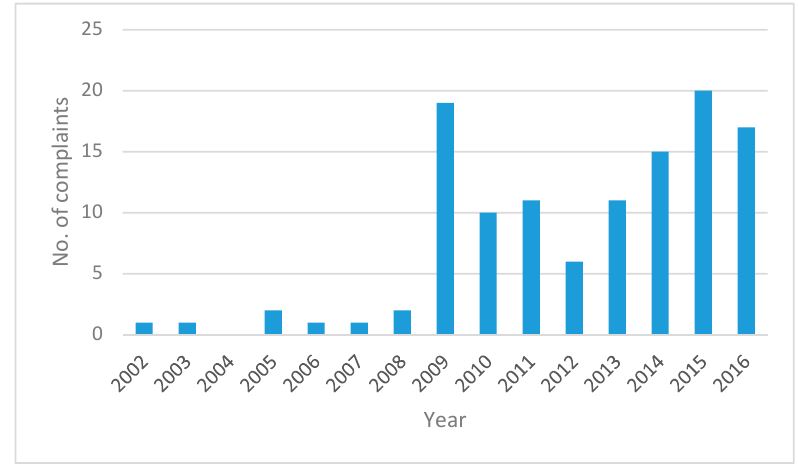
Figure 1. Recorded heat-related formal complaint calls to SafeWork SA (known as Workplace Services pre 2005) over the period 2002–December 2016. The Help Centre was established in 2009.